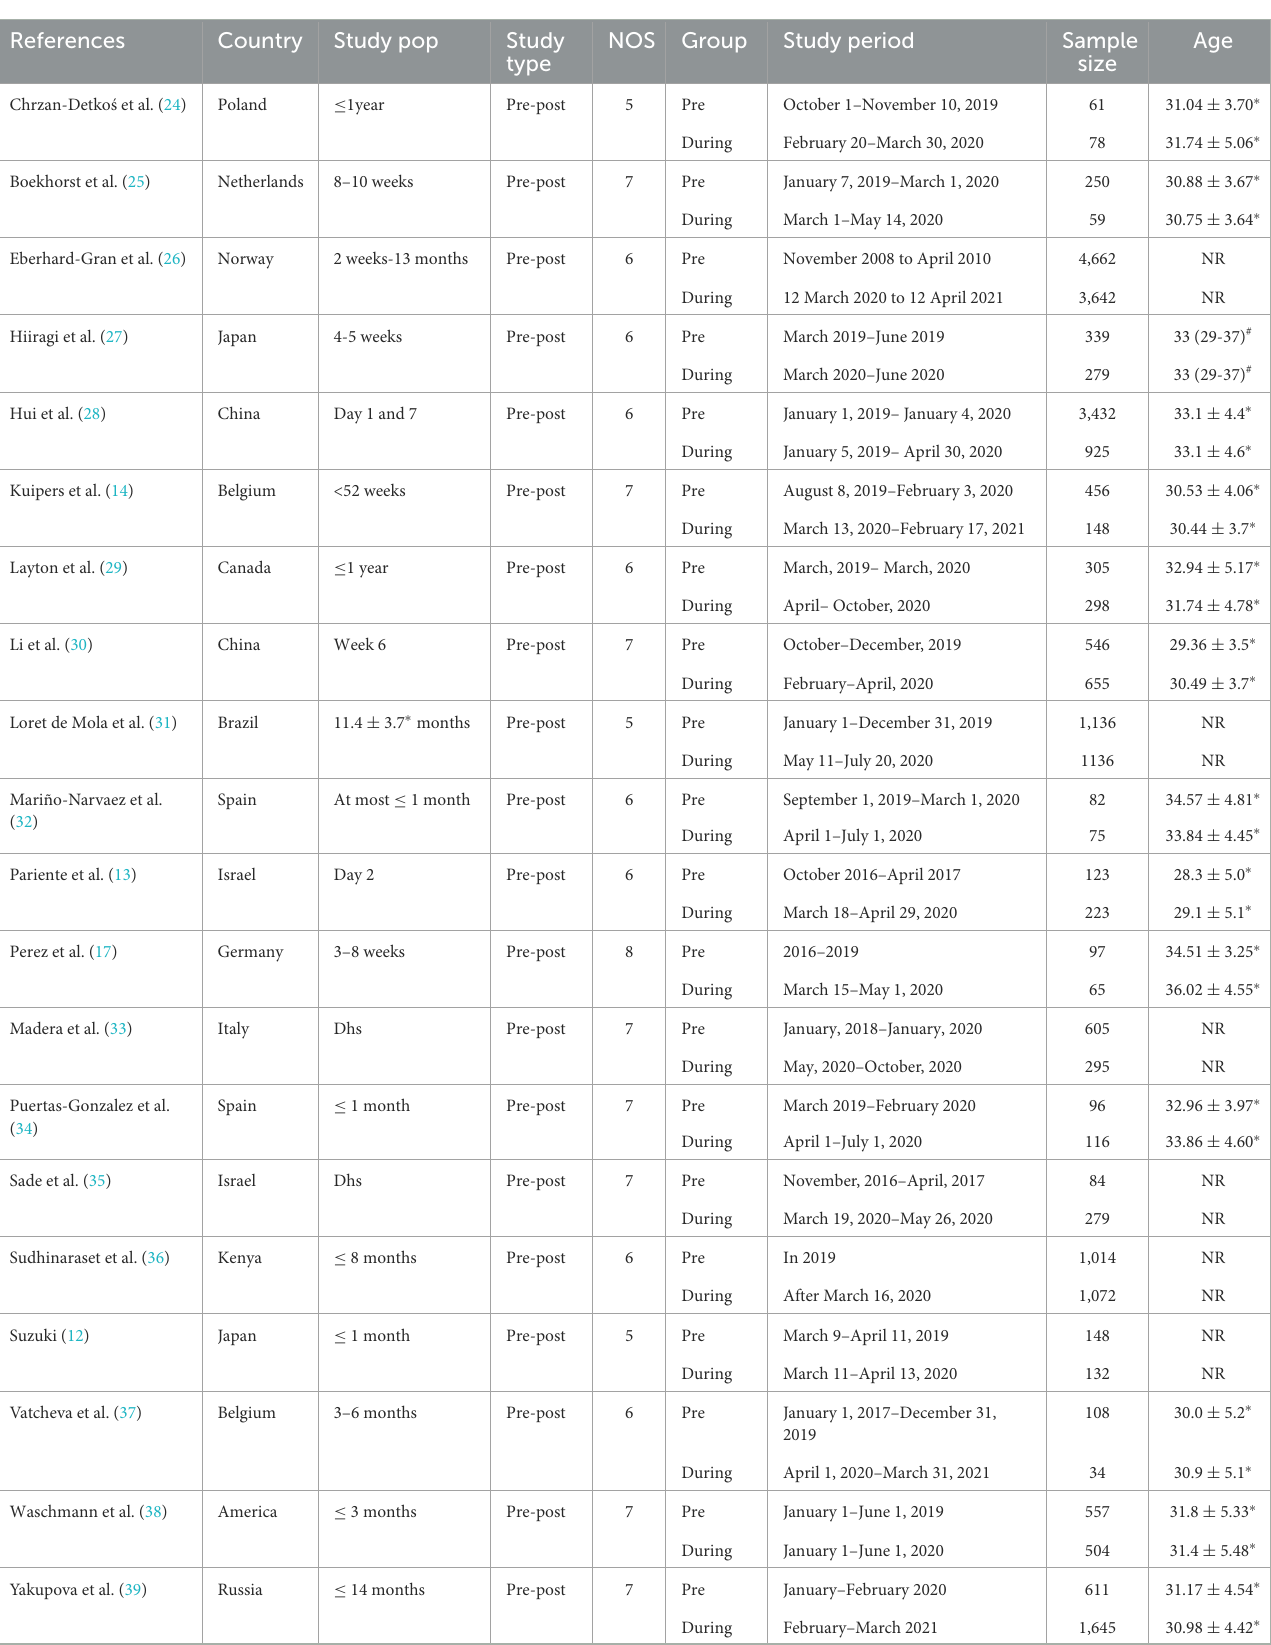
TABLE 1 Characteristics of the included studies on postpartum depression (before COVID-19 vs. during